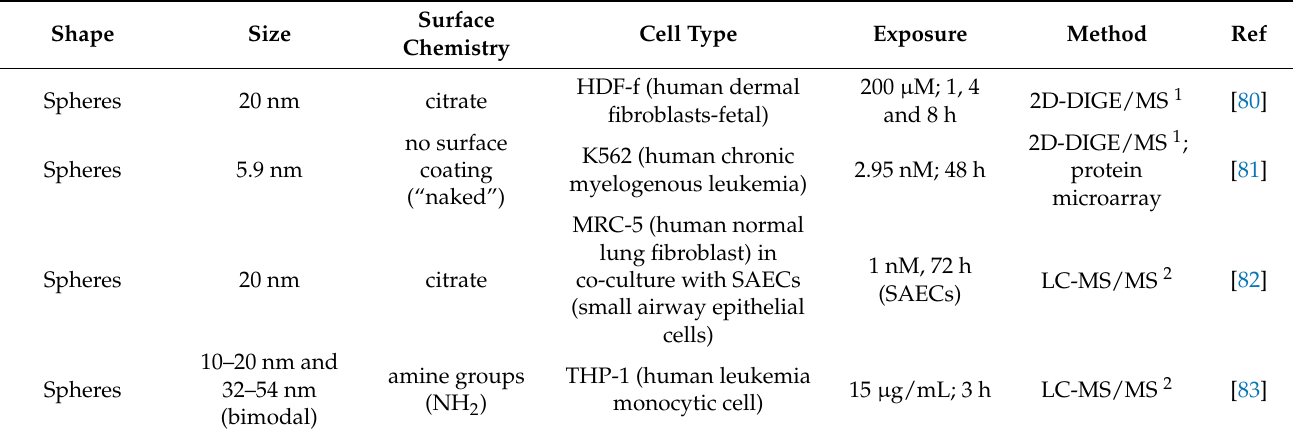
Table 3. Examples of proteomics changes induced by AuNPs in